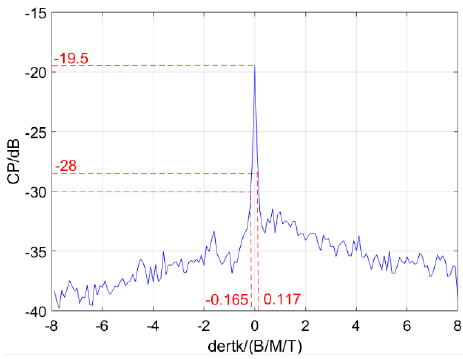
∆ k when k B ) q = 8 ( MT